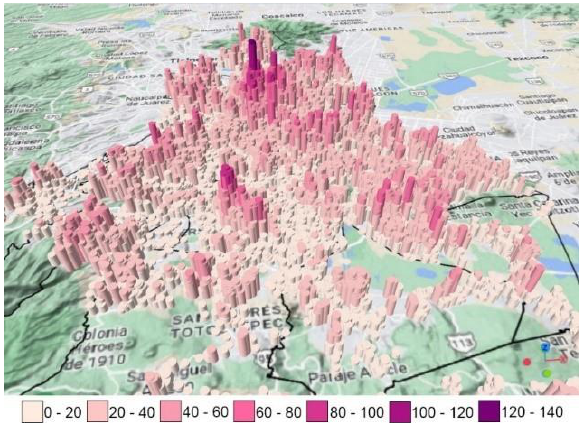
Figure 6. Hotspots of gender crimes occurring around educational services.